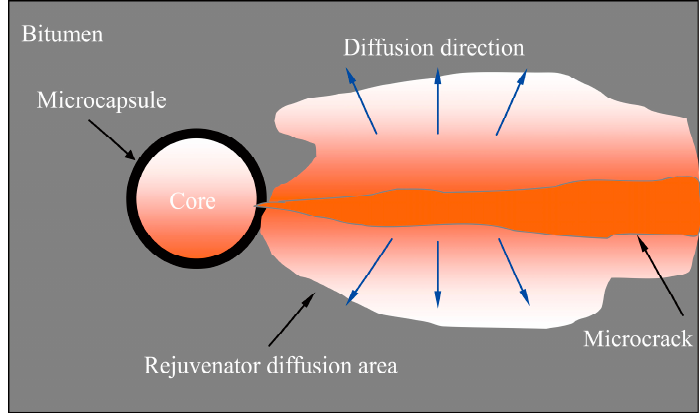
Figure 1. Illustration of the diffusion process of microencapsulated rejuvenator into bitumen.